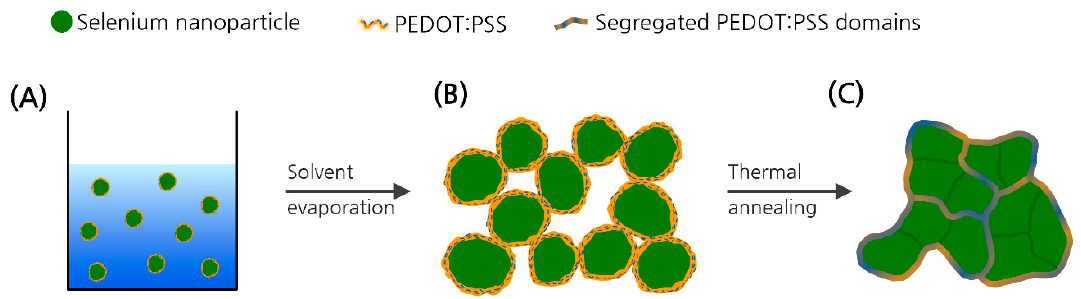
Figure 1. Schematic diagram of e ff ective percolation of poly(3,4-ethylenedioxythiophene):poly(styrene sulfonate) (PEDOT:PSS) between stacked Se nanoparticles in the PEDOT:PSS / Se composite film. ( A ) PEDOT:PSS / Se core-shell nanoparticles in solution. ( B ) Segregated networks of PEDOT:PSS between the stacked particles after solvent evaporation. ( C ) Further segregated polymer networks from the sintered particles upon thermal annealing to form more continuous domains running across the Se domains.